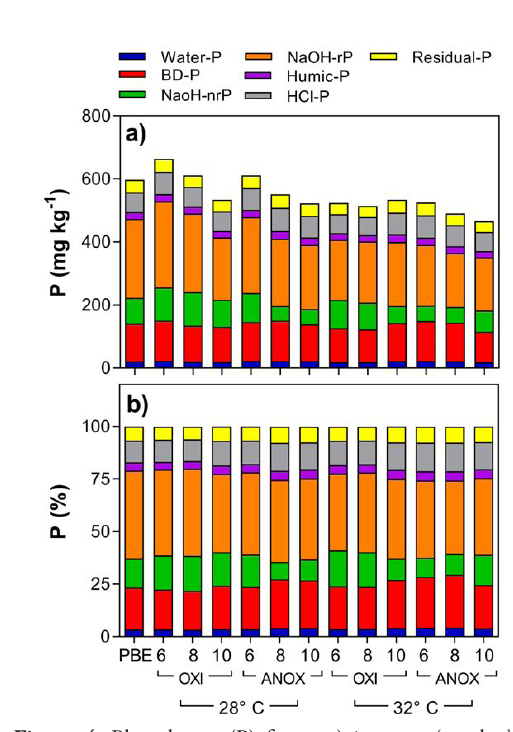
Figure 4. Phosphorus (P) forms a) in mass (mg kg -1 ) and b) in percentage (%) present in upper 10 cm of the Boqueirão reservoir sediment. *PBE = P before the experiment. BD = bicarbonate dithionite. OXI = oxic treatment (DO > 5 mg L -1 ), ANOX = anoxic treatment (DO < 1 mg L -1